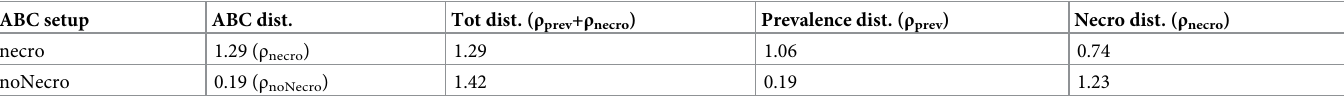
Table 6. ABC distances. ABC setup